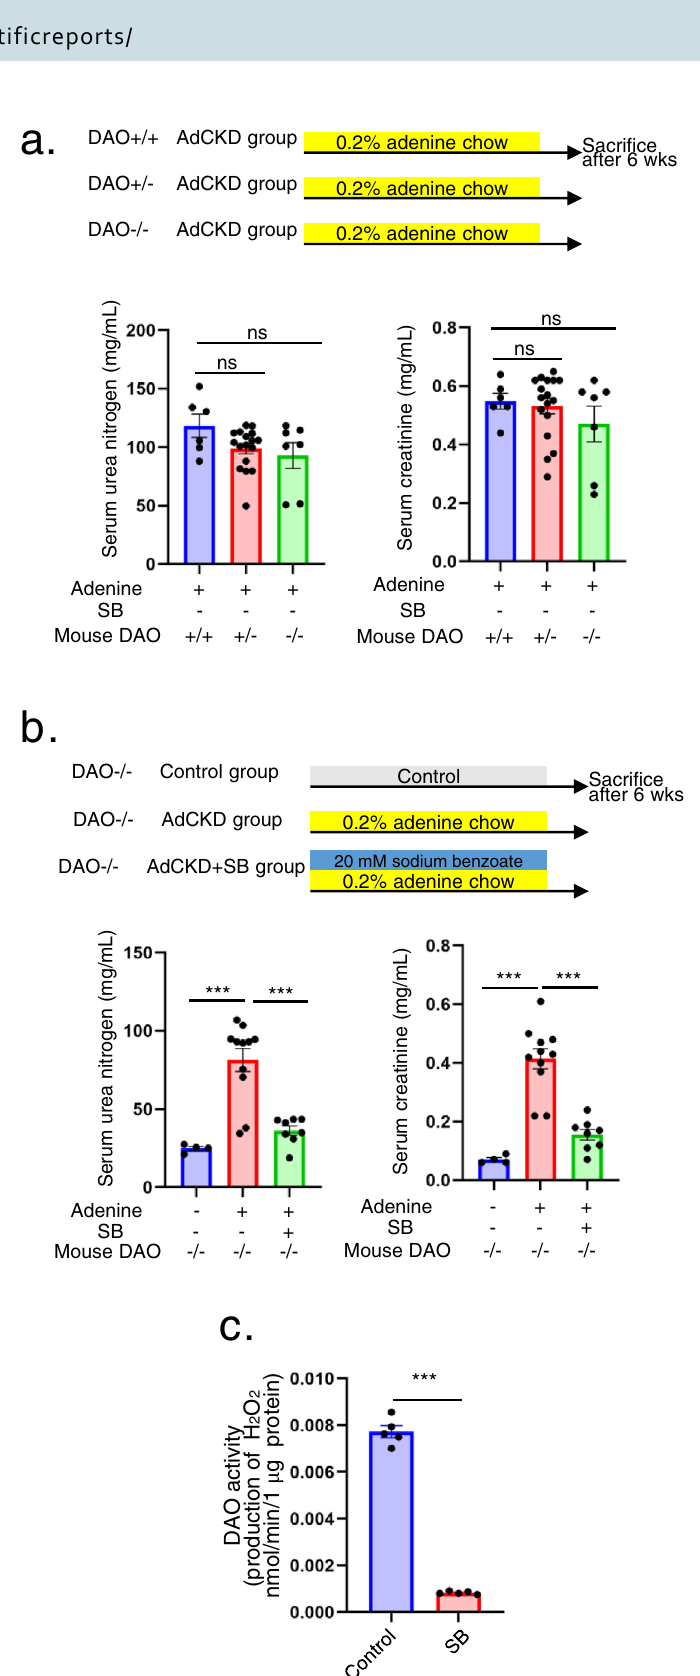
Figure 2. AdCKD is attenuated by SB regardless of DAO enzymatic activity. ( a ) AdCKD was induced in DAO + / + , DAO + / − , and DAO-/- littermates and plasma urea nitrogen and creatinine concentrations compared (n = 6–17). ( b ) DAO − / − mice were divided into control, AdCKD, and AdCKD + SB groups. SB significantly reduced plasma urea nitrogen and creatinine concentrations (n = 4–11). ( c ) DAO activity assay of normal kidney homogenate shows SB significantly reduced DAO activity (n = 5 each). *** p < 0.001; ns, not significant. Each bar represents mean ± SEM. AdCKD, adenine induced chronic kidney disease; DAO, D-amino acid